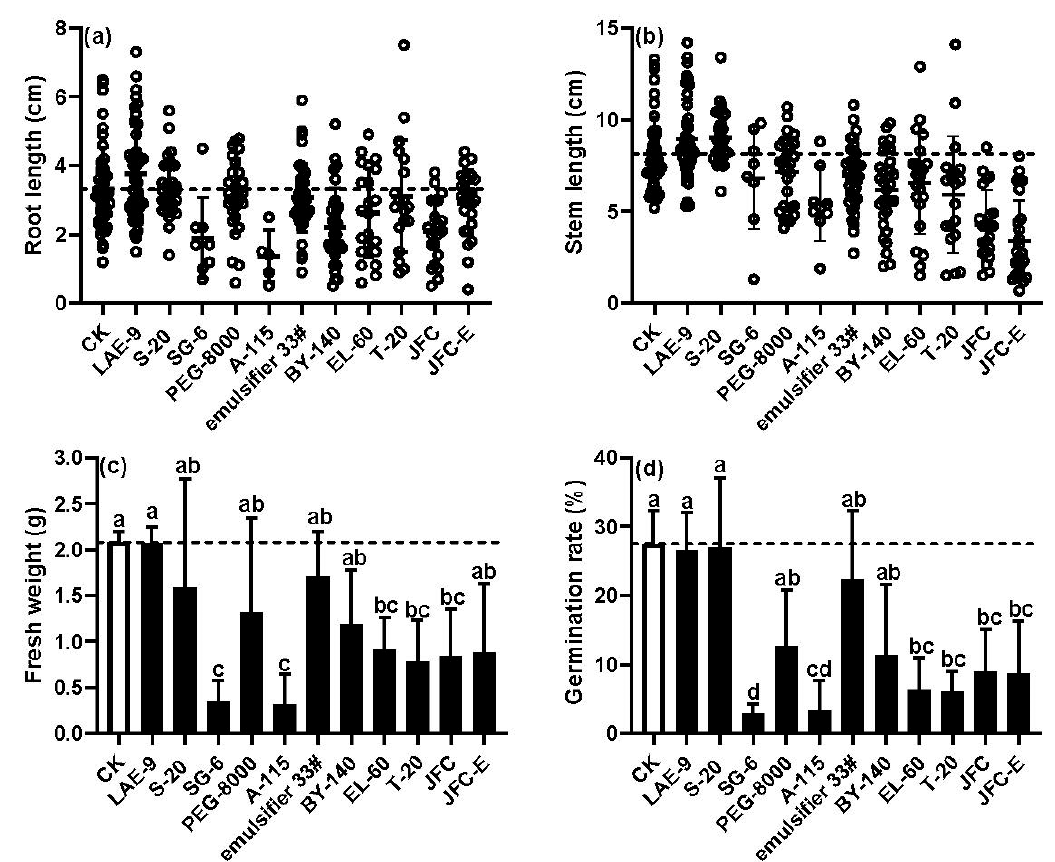
Figure 1. The e ff ect of nonionic surfactants on the root length ( a ), steam length ( b ), fresh weight ( c ), and germination rate ( d ). Bars with di ff erent lowercase letters are significantly di ff erent (one-way ANOVA followed by Tukey’s multiple comparison test; p < 0.05). Table 2. The effect of different film former on seedling quality.